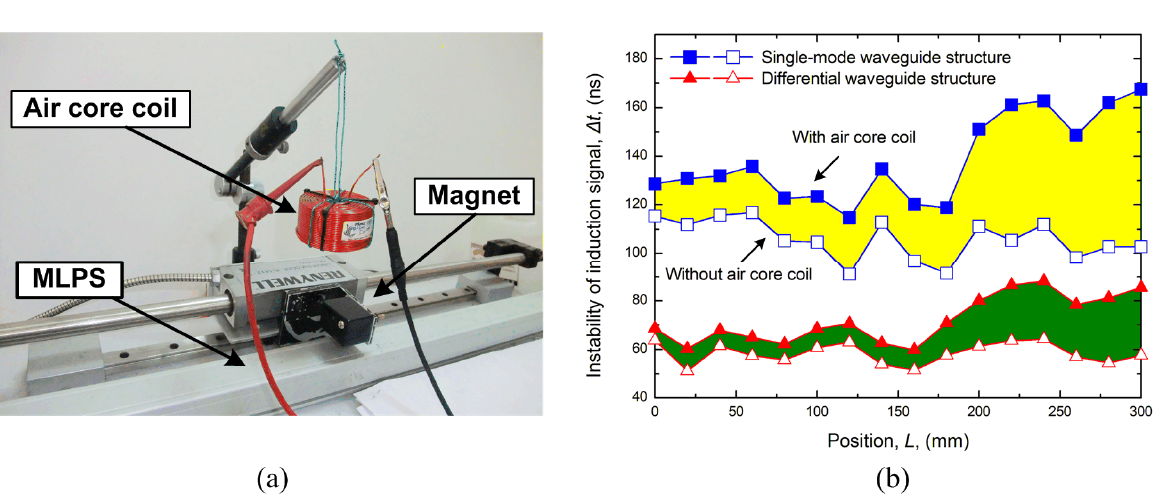
Figure 10. CMMR test with the air core coil (a) Experimental setup; (b) Comparison of induction signal instability with the perturbation.